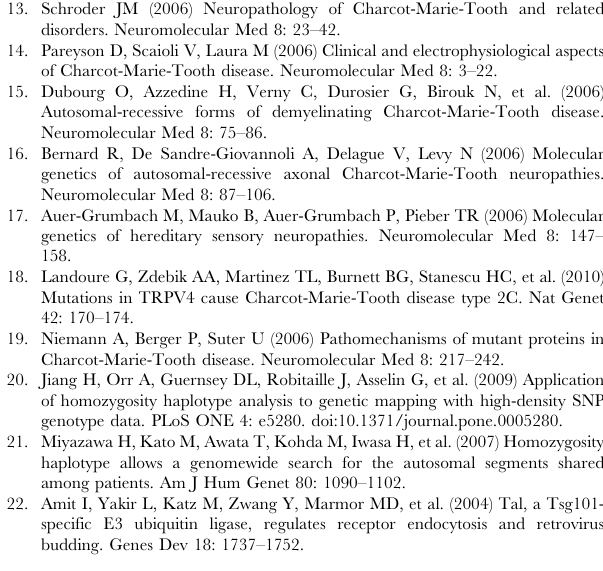
Table S1 Nerve conduction study of proband. Normal values in brackets. Abbreviations: NR (not recordable), EDB (extensor digitorum brevis), AH (abductor hallucis), APB (abductor pollicus brevis), ADM (abductor digiti minimi).